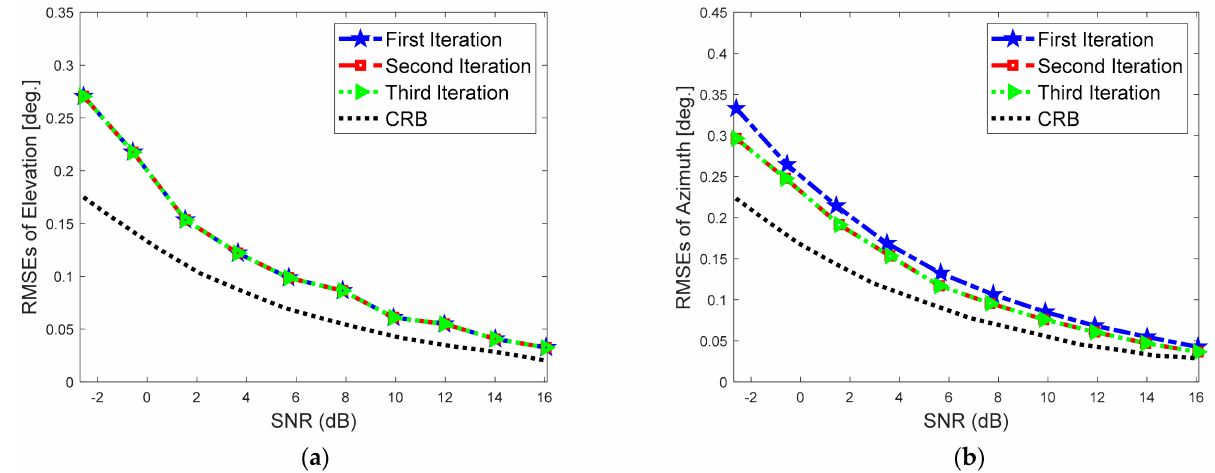
Figure 4. RMSEs of the estimates ( a ) Elevation ( b ) Azimuth for various iterations with two sources.